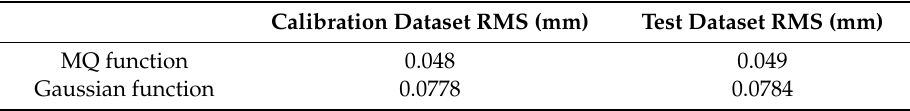
Table 2. Error valuation of calibration dataset and test dataset.